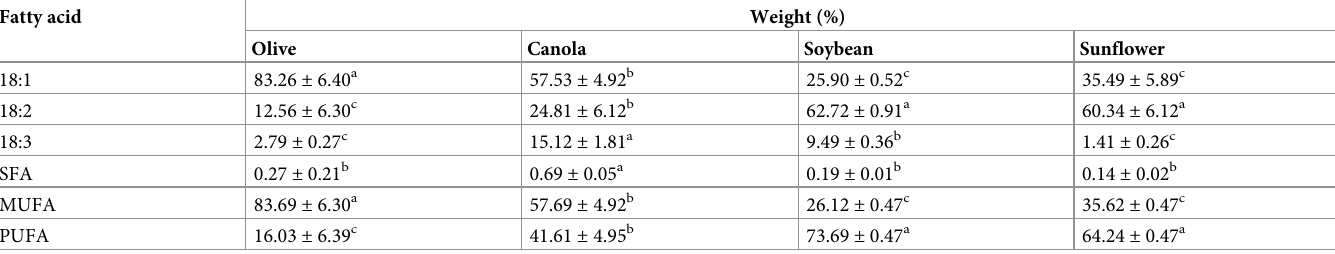
Table 2. Composition of major fatty acids, SFA, MUFA, and PUFA in vegetable oils. Fatty